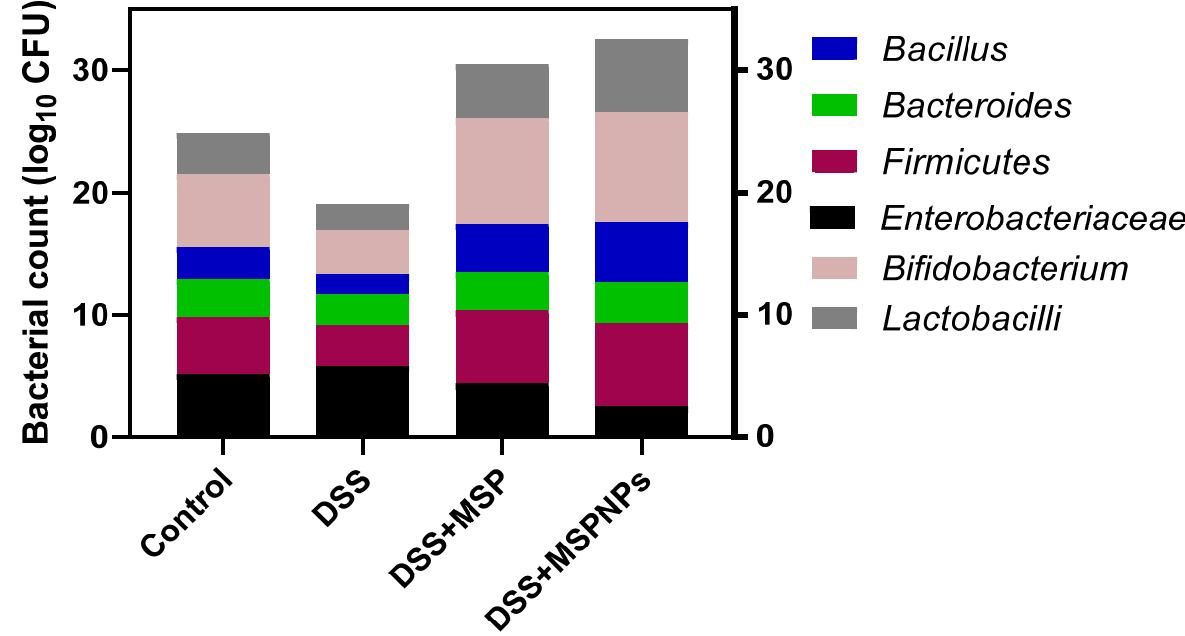
Figure 6. Effects of orally administered multi-strain probiotics (MSPs) or multi-strain-probiotic- loaded nanoparticles (MSPNPs) on abundance of Bacillus , Bacteroides , Firmicutes and Enterobacteriaceae Bifidobacterium populations and lactobacilli (log 10 CFU), 7 days post DSS induction. Non-colitic group: Control (rats were orally gavaged with PBS). Colitic groups including: DSS (rats were orally gavaged with dextran sodium sulphate), DSS + MSPs (rats were orally gavaged with DSS and multi- strains probiotics (MSPs at the level of 1.0 × 10 10 CFU/kg in 1 mL of PBS/rat/day for 14 days), DSS + MSPNPs (rats were orally gavaged with DSS and multi-strain-probiotic-loaded nanoparticles (MSPNPs) at the level of 1.0 × 10 10 CFU/kg in 1 mL of PBS/rat/day for 14 days); all groups were orally gavaged with 5% DSS.